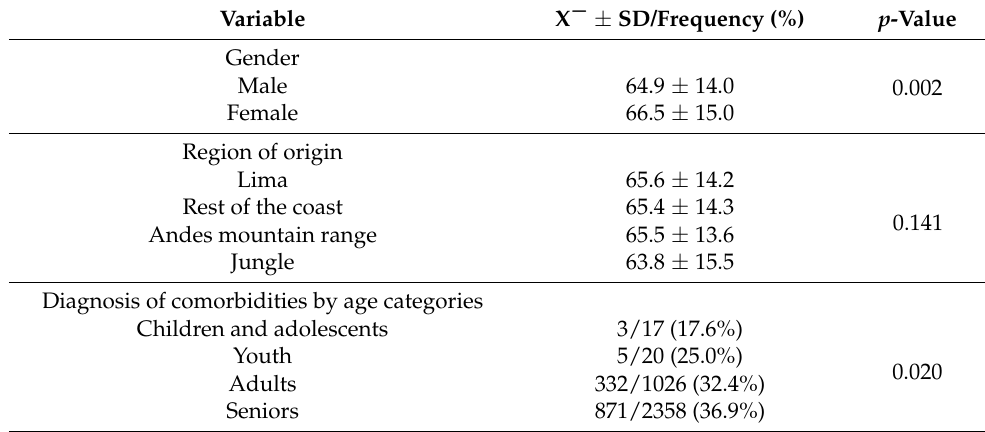
Table 3. Stratified analysis of the epidemiological characteristics of deaths confirmed by COVID-19 in